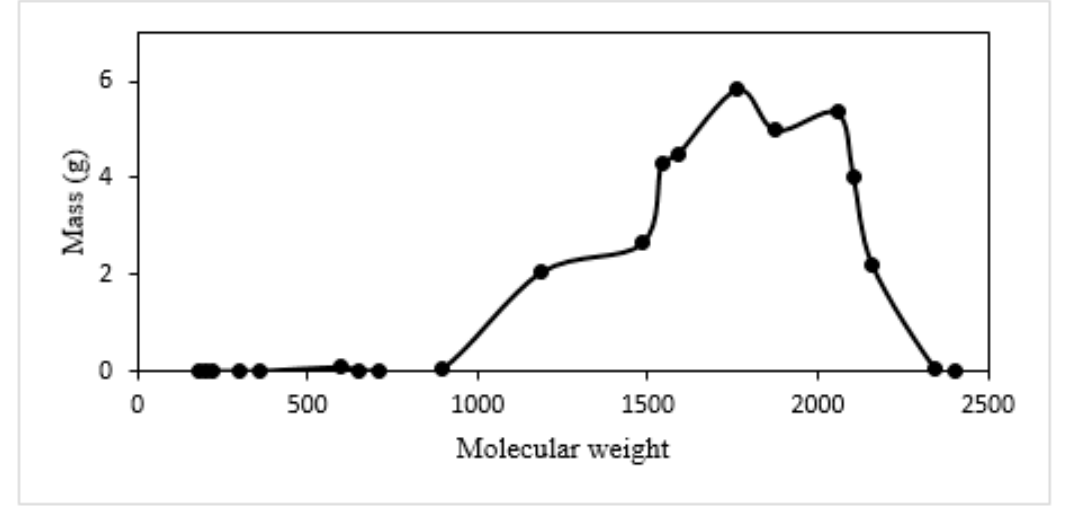
Figure 15. Calculated molecular weight distribution of the residue of a 50 g mass coal tar pitch at the end of semi-coke formation step of carbonization process with heating rate of 50 °C/h.